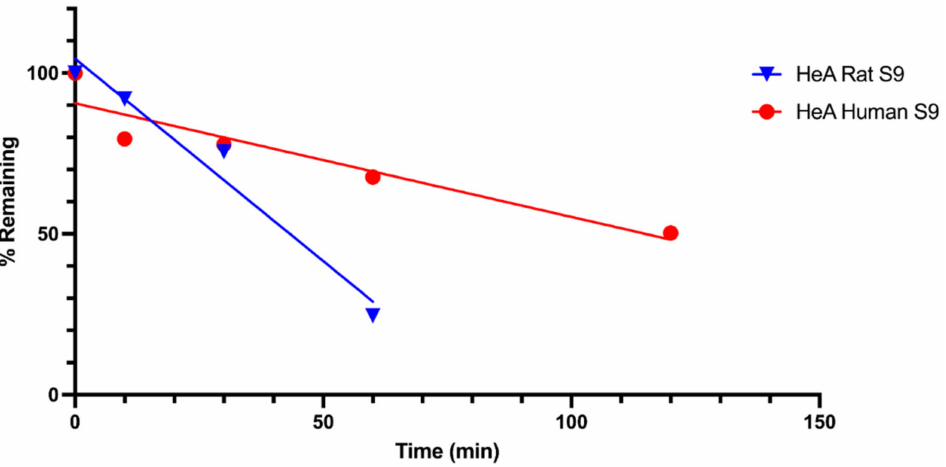
Figure 1. Erinacine A remaining versus time profile in rat and human liver S9. Data is presented in mean values of triplicate measurements. Table 1. Hepatic metabolic stability of erinacine A in rats and humans.